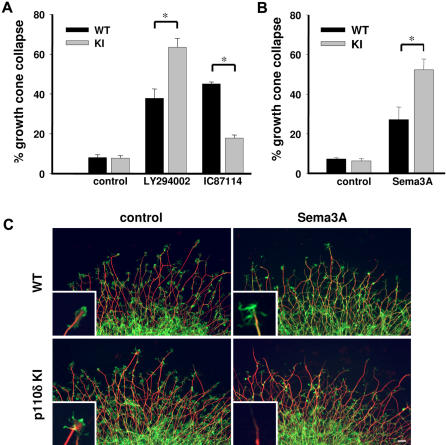
Increased sensitivity of p110δ KI DRG growth cones to collapse in response to PI3K inhibition or Sema3A treatment.(A) Growth cone collapse in DRG explants induced by LY294002 (a pan-PI3K inhibitor) or IC87114 (a p110δ-selective inhibitor). Both drugs were used at 10 µM for 10 min (n≥6 independent experiments). *p<0.01. (B) E13.5 DRG explants were cultured for 24 h on 20 µg/ml laminin and treated with Sema3A (0.3 µg/ml) for 30 min. Increased growth cone collapse in response to Sema3A (0.3 µg/ml) in p110δ KI DRGs (right). Each data point represents the %±SEM (n≥3 independent experiments). In each experiment at least 80 growth cones were counted. *p<0.02. (C) Example of DRG explants in each group, which have been stained for βIII-tubulin (red) and phalloidin (green). Scale bar, 20 µm.